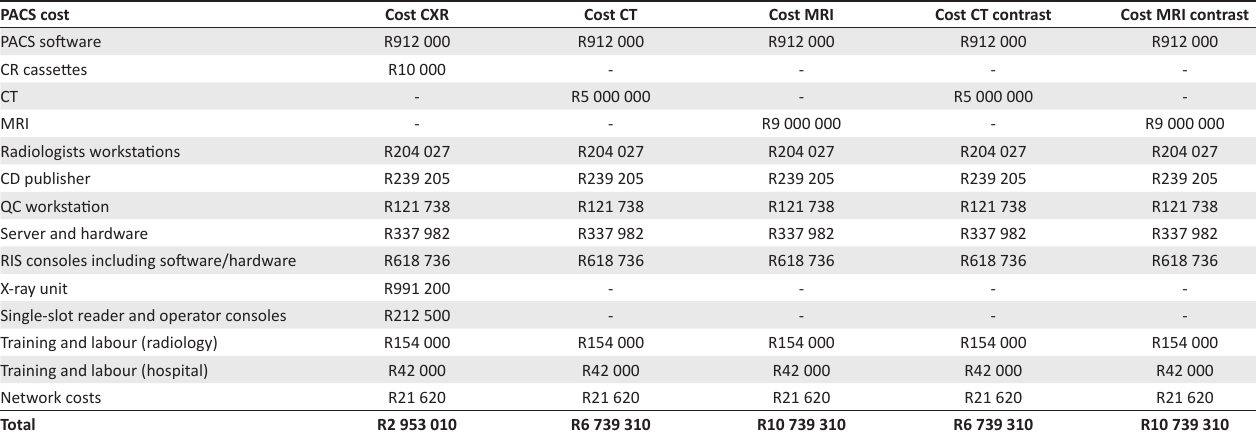
TABLE 2: Overall costs for chest radiographs and CT and MRI brain scans using the PACS system.